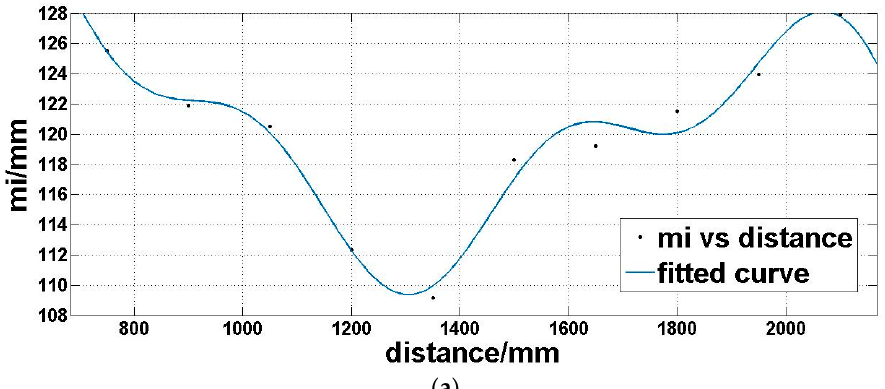
Figure 7. Red box region at distance 0.75 m: 3D view ( top ); side view ( bottom ).